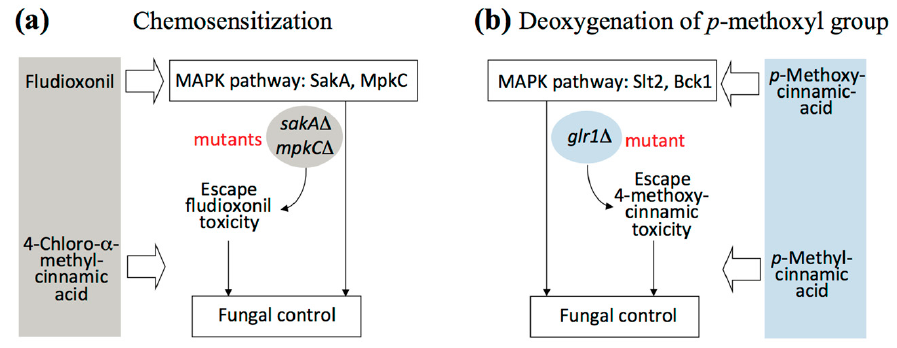
Figure 5. Scheme showing overcoming fungal tolerance to antifungal agents. ( a ) Chemosensitization to overcome fludioxonil tolerance of A. fumigatus MAPK mutants by small molecule chemosensitizer 4-chloro- α -methylcinnamic acid; ( b ) Deoxygenation of 4-methoxyl group to overcome 4-methoxycinnamic acid tolerance of S. cerevisiae glr1 Δ mutant.